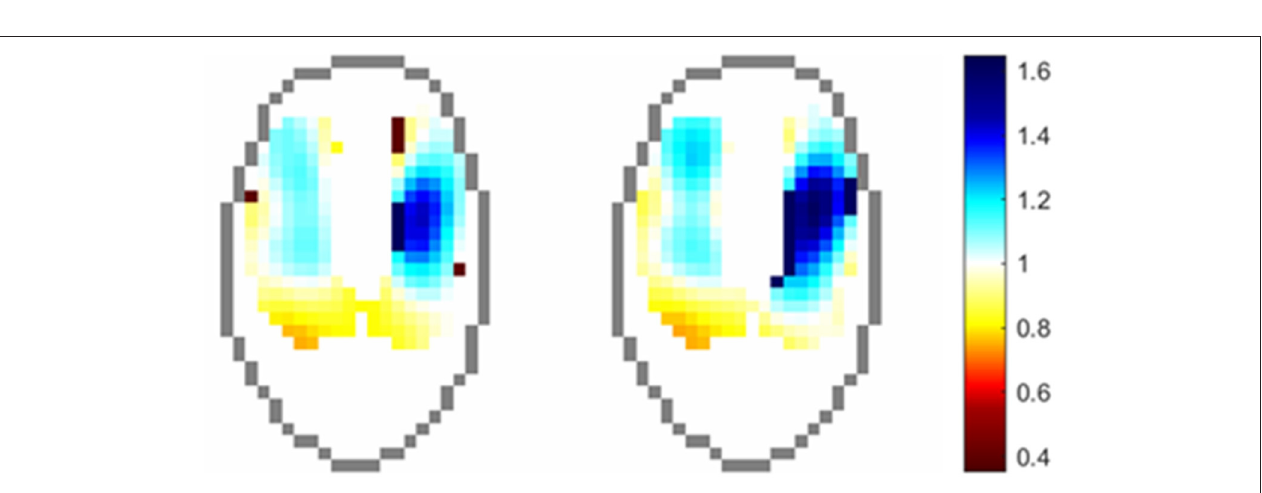
FIGURE 15 | Regional distribution of VQ ratios in an anesthetised horse. Pixels values are the ratio of normalised ventilation to normalised perfusion at each time